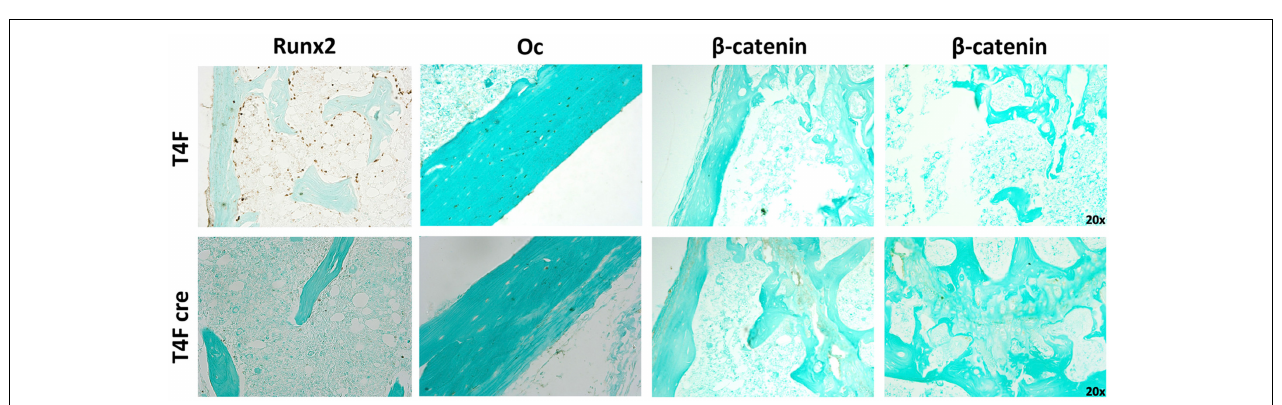
FIGURE 7 | T4F cre mice have significantly reduced levels of key regulators of bone development and osteoblast function. Immunohistochemistry assay using femurs harvested from T4F cre mice of 8-to-9 days old in MAR assay reveals decrease in Runx2 and Oc levels and increased β -catenin signals in the epiphyseal and cortical areas compared to T4F control counterparts ( n = 3 mice per arm, representative